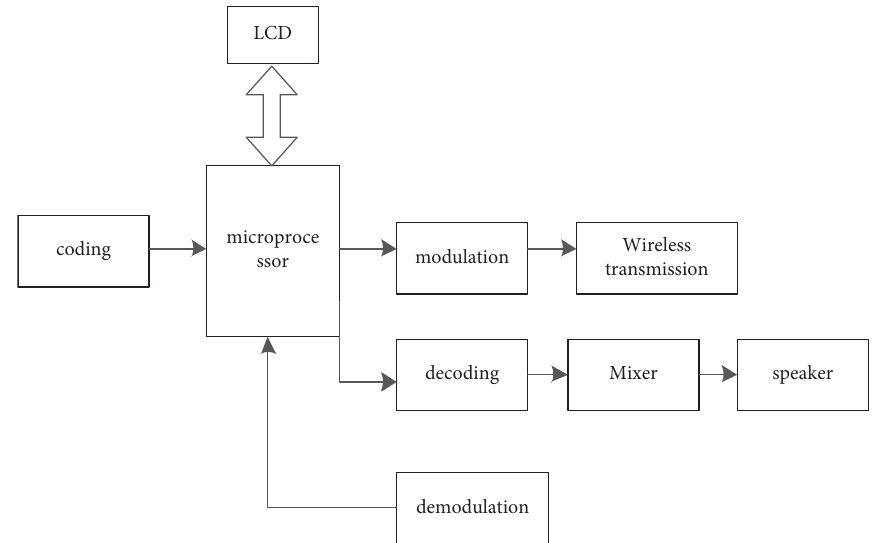
Figure 3: Block diagram of chairman machine